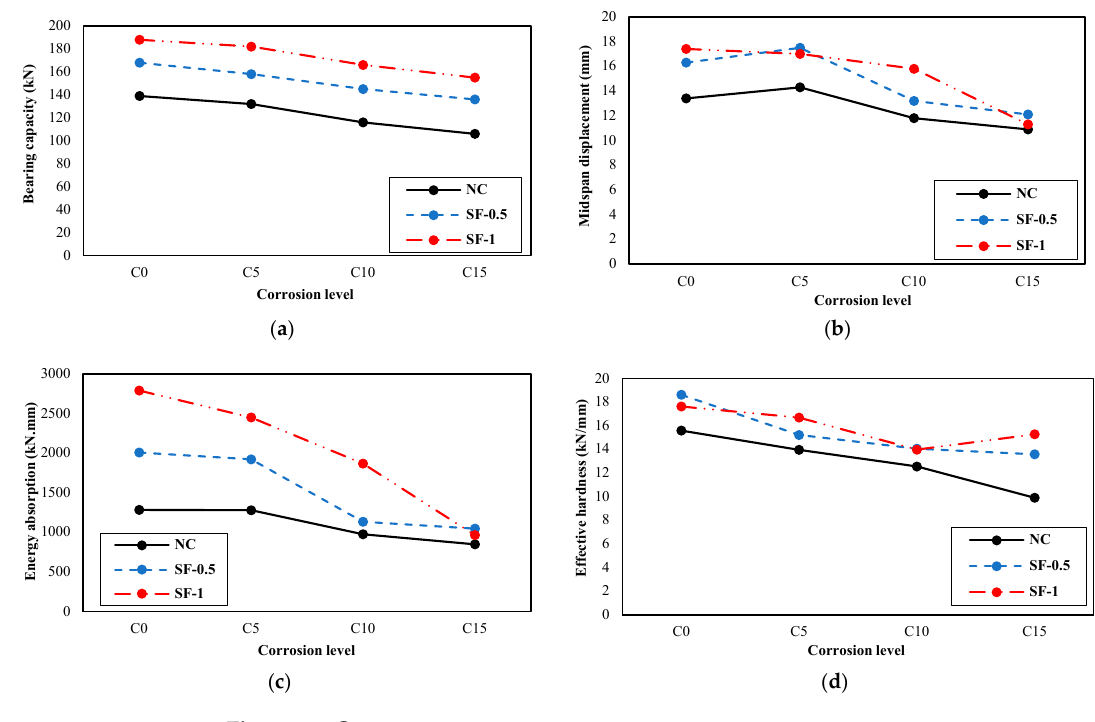
Figure 15. Displacement longitudinal profile diagrams: ( a ) Group A specimens ( b ) Group B speci- mens ( c ) Group C specimens ( d ) Group D specimens. Displacement longitudinal profile diagrams of all beams are asymmetric, and the value of displacement in the half of the failing beam is greater than in the other half.